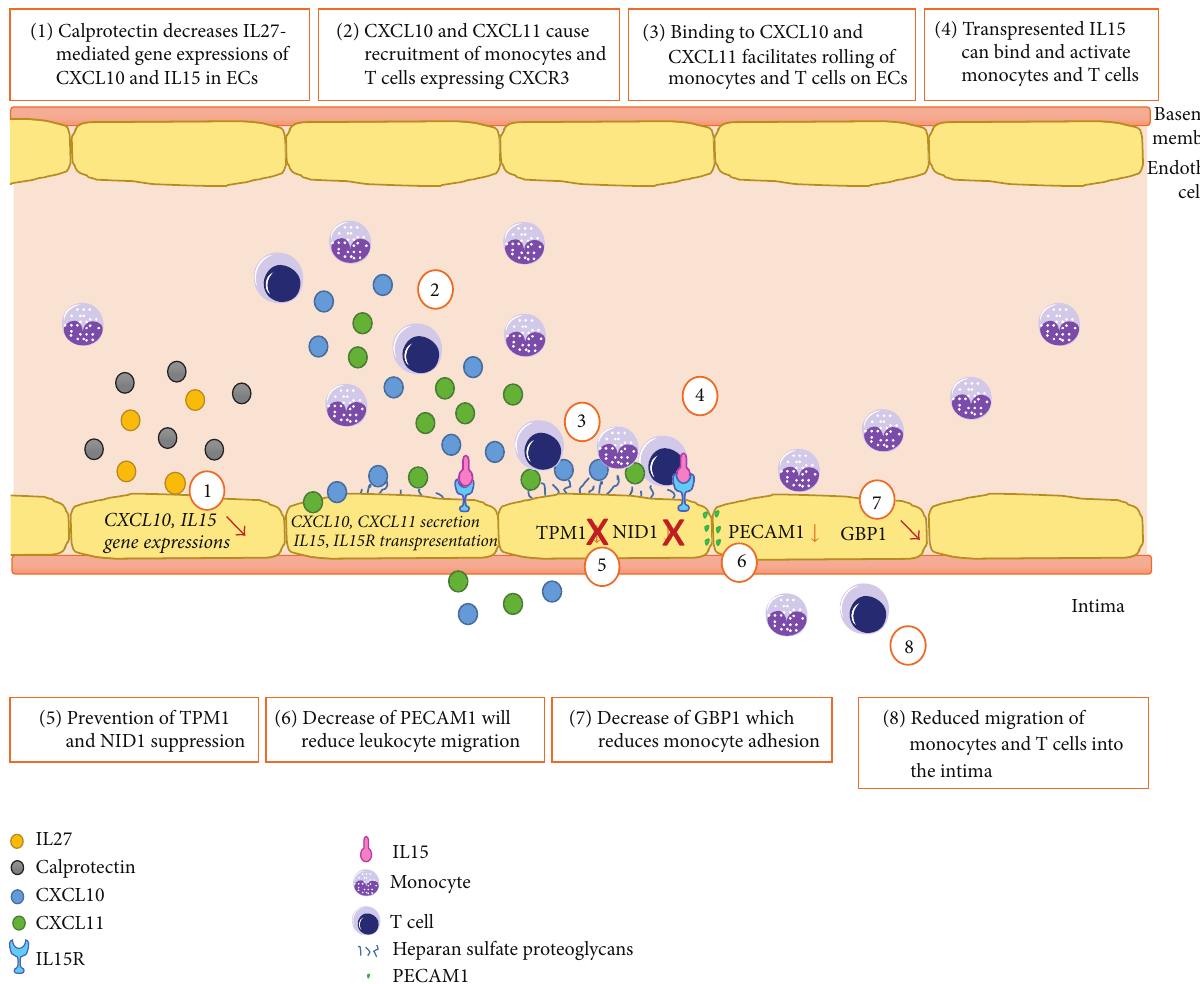
Figure8:HypotheticalmodelofthecalprotectinmodulatoryeffectsonIL27-mediatedgeneandproteinexpressionbasedonourexperimental results and literature data. GBP1, guanylate binding protein 1; NID1, nidogen-1; PECAM1, platelet endothelial cell adhesion molecule; TPM1, tropomyosin